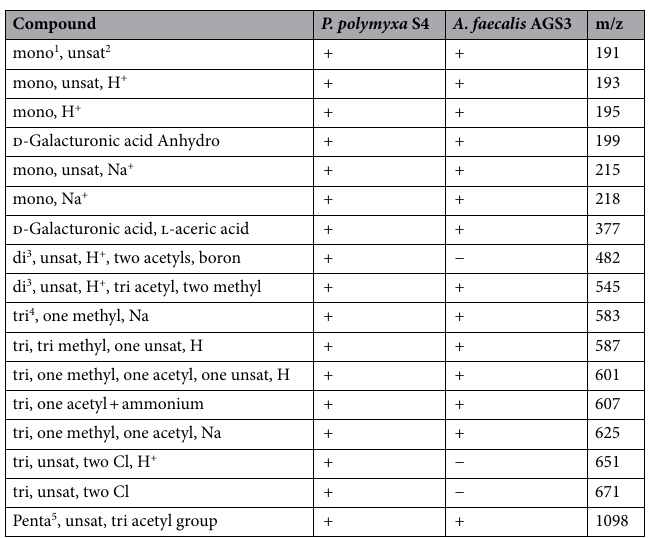
Table 1. Identified compounds obtained from the pectinolytic activity of A. faecalis AGS3 and P. polymyxa S4 by analysis of their LC–ESI–MS spectrums. + represents the presence and, − represents absence.